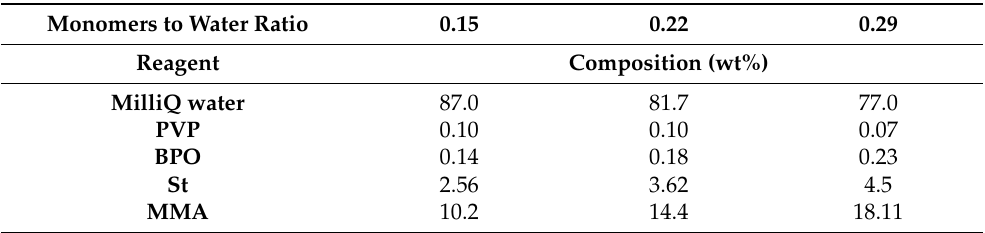
Table 1. Reaction recipe for the optimization of the monomers to water ratio in the synthesis of St-MMA particles. Monomers to Water Ratio